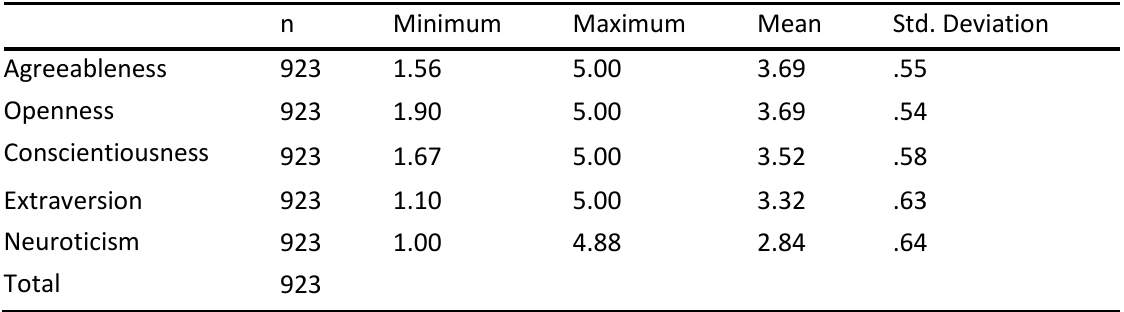
Table 1. Descriptive Statistics of Personality Traits of ELT Department Participants